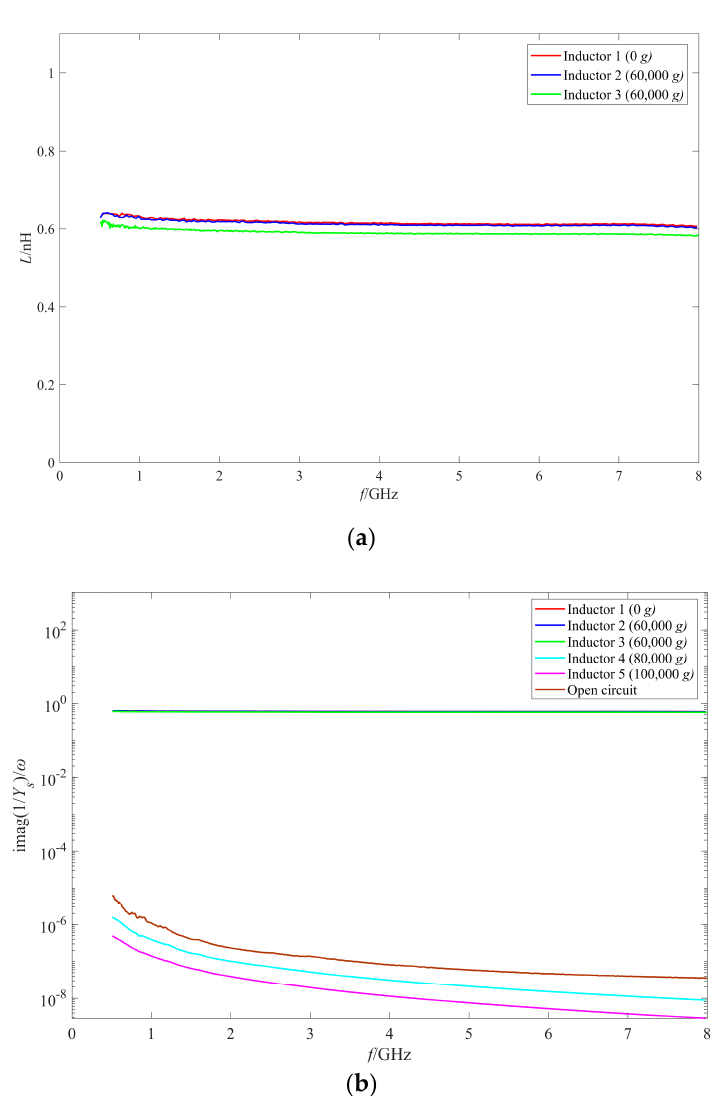
Figure 16. The inductance values of the inductors after shock test with different shock amplitude. ( a ) The inductance values of No.1–3 inductors; ( b ) The inductance values of No.1–5 inductors.